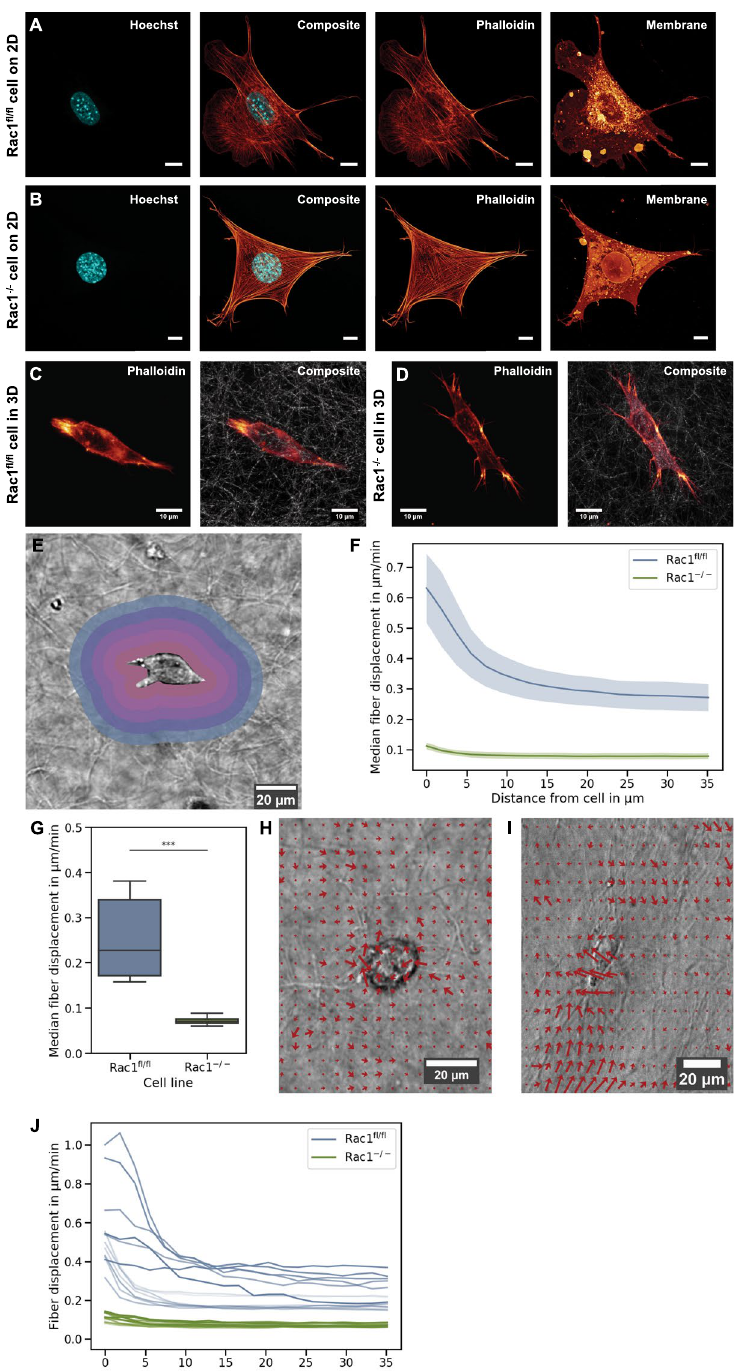
Figure 3. Altered actin cytoskeleton and morphological phenotype of Rac1 − / − cells (clone KO17) and Rac1 fl/fl cells in 2D compared to 3D microenvironments. Laser scanning confocal images of a representative Rac1 fl/fl cell ( A ) or representative Rac1 − / − cell ( B ) migrating on 2D planar glass substrates coated with laminin serving as controls for the 3D microenvironments. For both cell types on a 2D substrate, we present for each (from left to right) a 33342 Hoechst staining of the nucleus (blue), a composite image of Alexa Fluor 546 Phalloidin (red) staining of F-actin fibers and Hoechst staining of the nucleus (blue) and a DID staining of the membrane (red). All scale bars are 10 µ m. Laser scanning confocal images of a representative Rac1 fl/fl cell ( C ) and representative Rac1 − / − cell ( D ) that migrated through dense 1.5 mg/ml 3D collagen fiber networks. ( C , D ) Fluorescence image of a Rac1 fl/fl cell ( C ) or Rac1 − / − cell ( D ) stained with Alexa Fluor 546 Phalloidin after migration through a dense 1.5 mg/ml 3D collagen fiber network (left images) and same image combined with reflection mode image of the 3D collagen fiber network (right images). ( E ) Illustration of some sample shells around a representative invasive cell that were analyzed for the determination of the amount of fiber displacement around this cell. ( F )